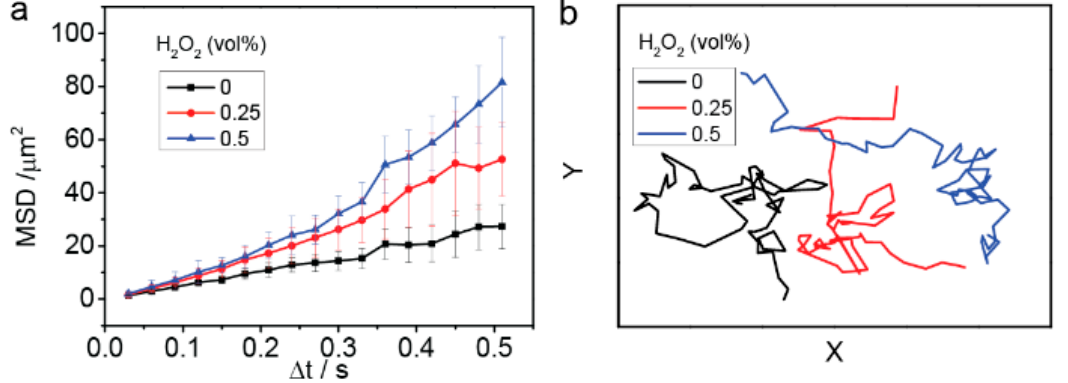
Figure 3. ( a ) Average mean square displacement (MSD) of the brush nanomotor in different concentrations of H 2 O 2 calculated from the tracking coordinates of 90 particles from the major size distribution. ( b ) Typical trajectories of the supramolecular nanomotor at 0, 0.25 and 0.5 vol % of H 2 O 2 . Table 1. Data for the brush nanomotor in pure water and hydrogen peroxide with different concentrations. H 2 O 2 (wt %)